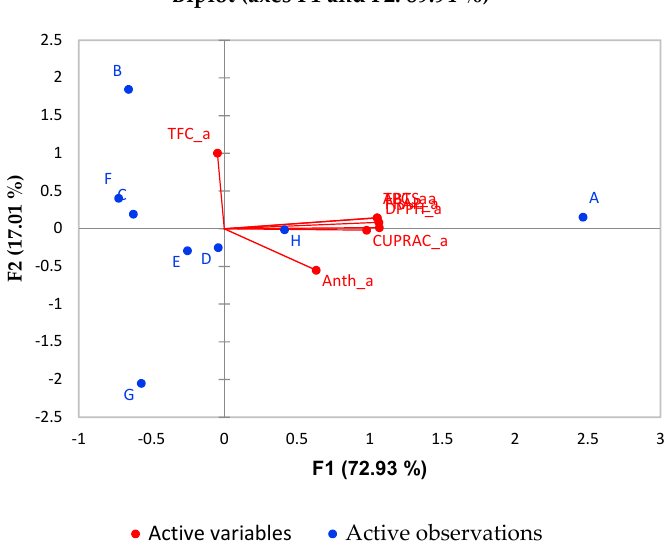
Figure 4. Biplot for PCA analysis of in vitro digested juices.